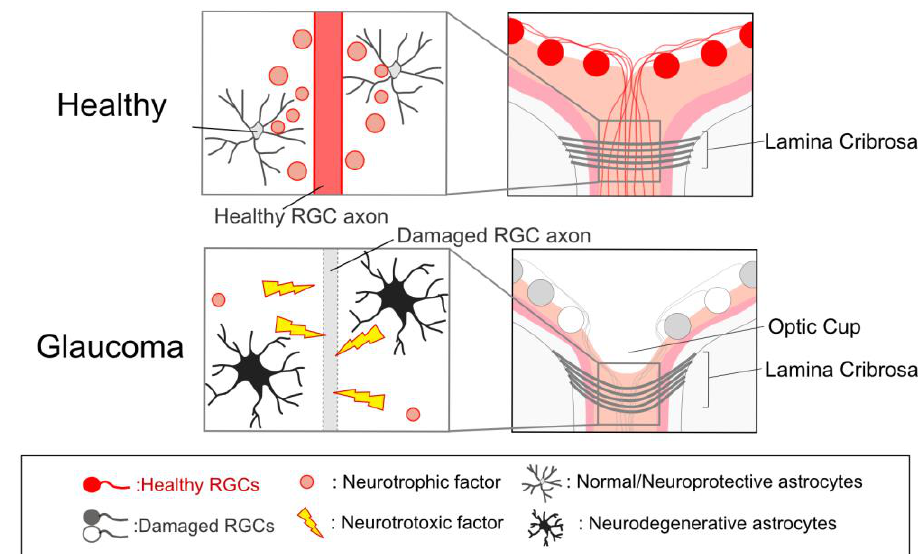
Figure 2. Cupping of the optic nerve